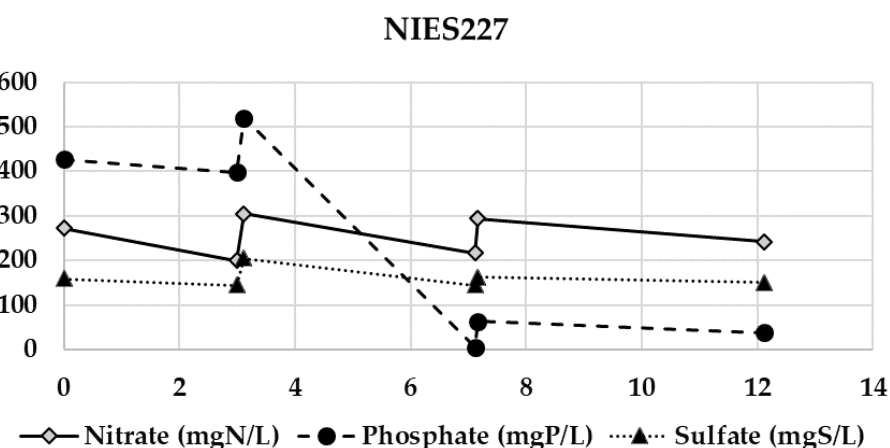
Figure A2. Evolution of the nitrate, phosphate, and sulfate concentrations during the semi-continuous test for NIES227.